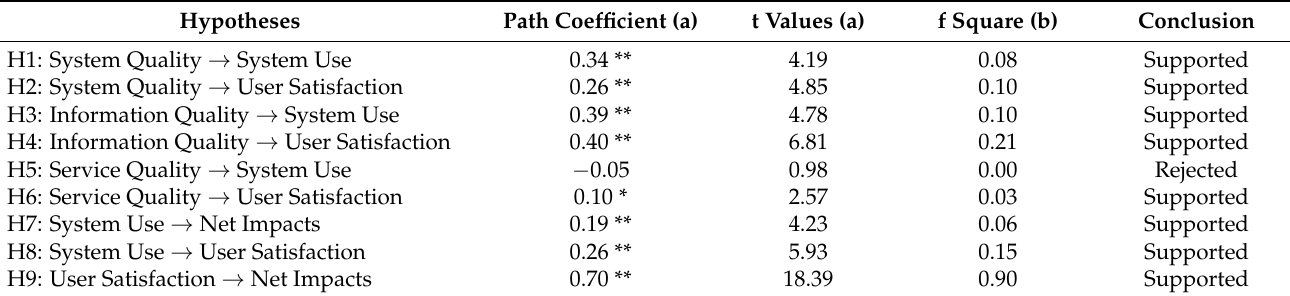
Table 6. Structural estimates (hypothesis testing).